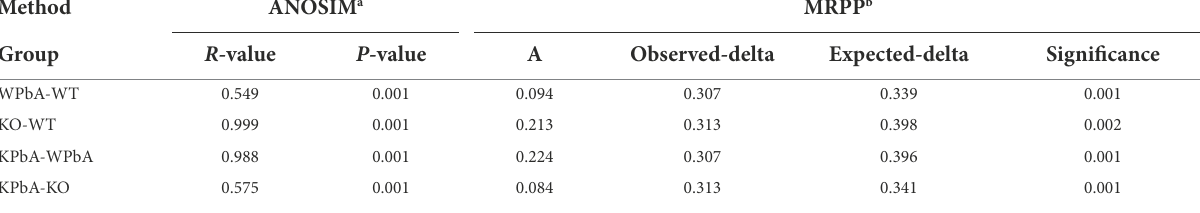
TABLE 2 Within- vs. among-group dissimilarities analysis via analysis of similarities (ANOSIM) and multi response permutation procedure (MRPP).